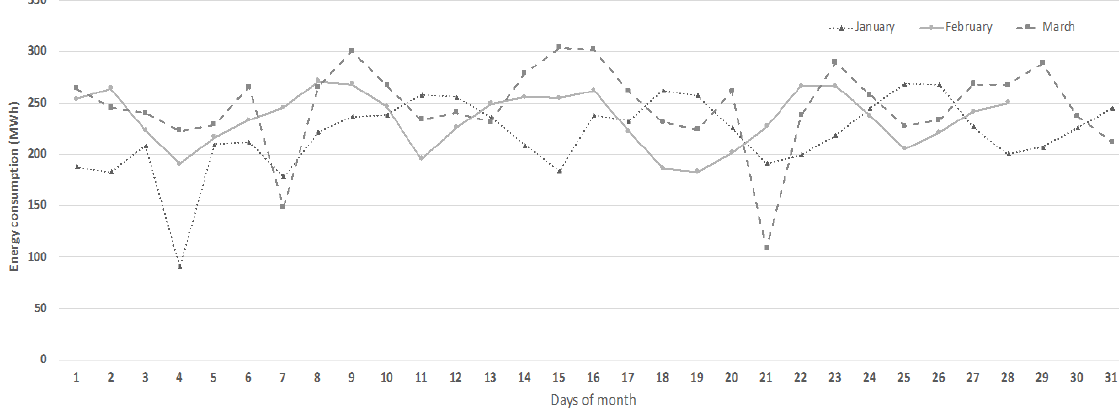
Figure 8. Energy consumption in winter, 2018.